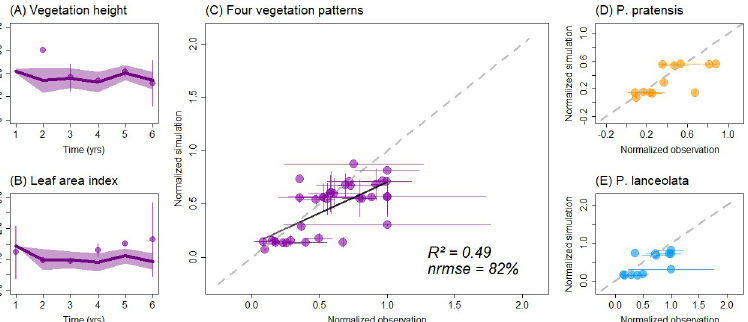
Fig 3. Comparison of observed and simulated patterns for the two-species-mixture. In (A-B) annual dynamics of AGB and LAI are shown. In (C-E) each dot represents an annual value compared between observation and simulation. In (A, D-E) species are marked by different colors (yellow and blue). In (C) all results are combined and normalized by the maximum value (of observations and simulations per selected pattern). In (D) the observed AGB and vegetation cover is compared with the simulated values only for P . pratensis within the mixture, while in (E) both patterns are shown only for P . lanceolata ’s contribution in the mixture (again normalized by their respective maximum values).